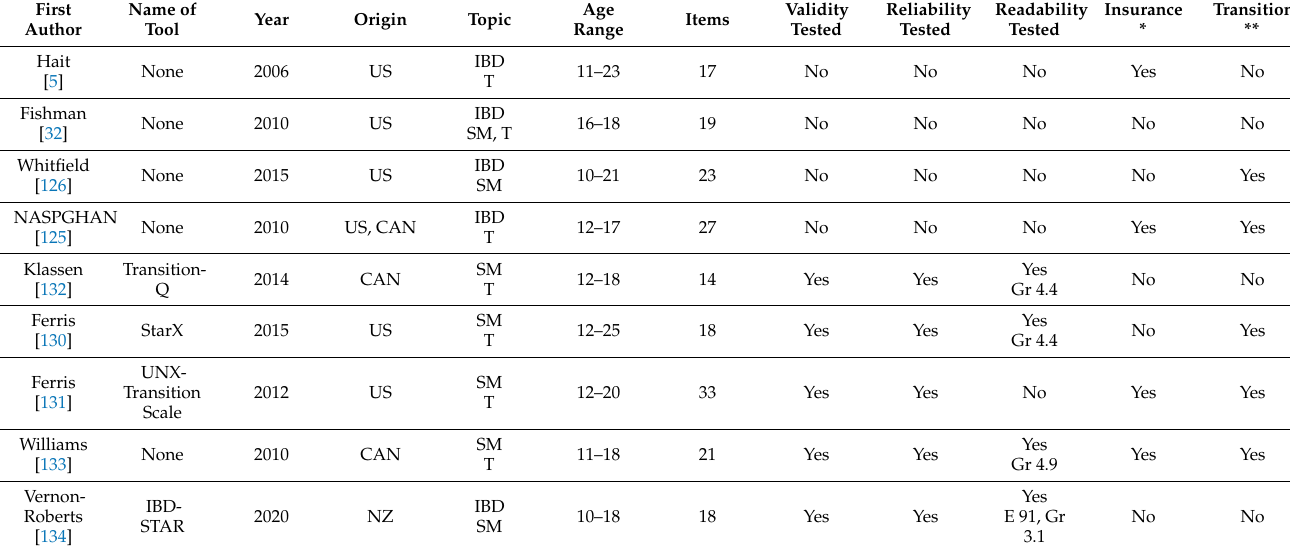
Table 2. Summary of self-management skills assessment tool features to determine which is appropriate for target